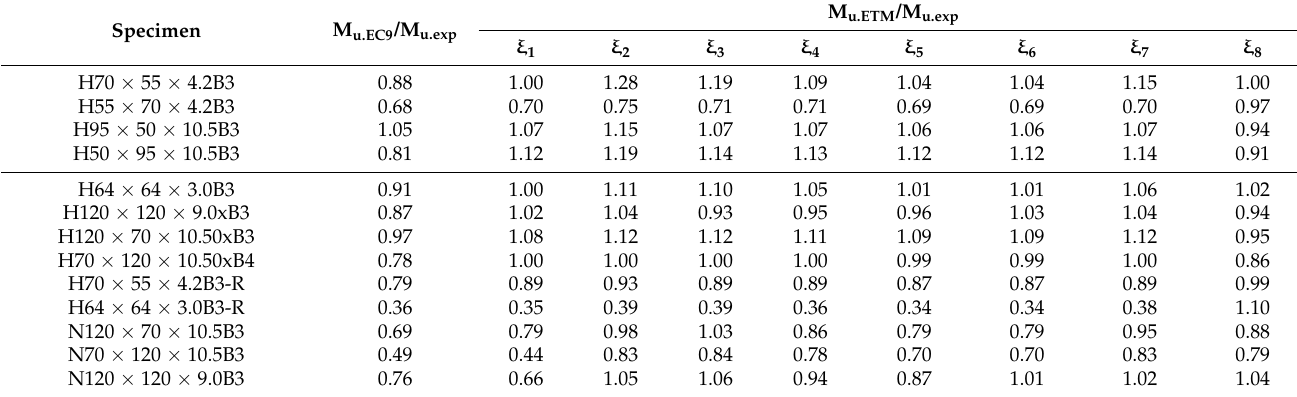
Table A6. Ratio values between the theoretical and experimental results in the case of bending